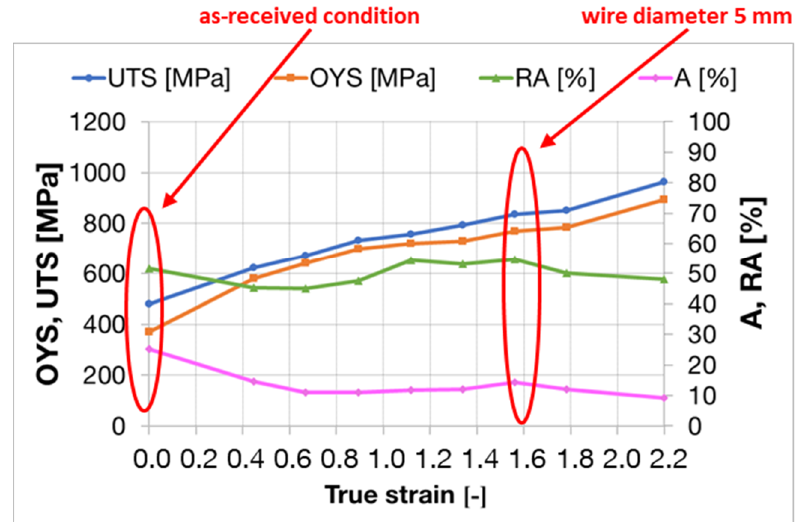
Figure 16. Results of tensile testing for titanium Grade 4 after one Conform SPD pass and rotary swaging as a function of the true strain induced by rotary swaging.